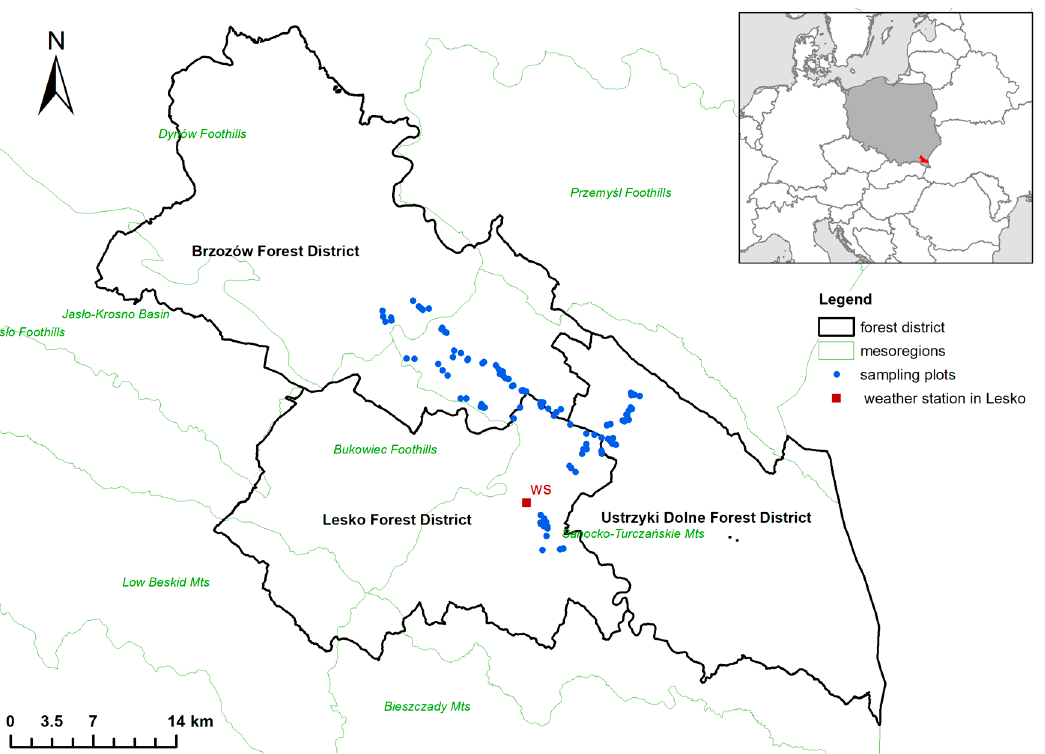
Figure 1. Location of the study